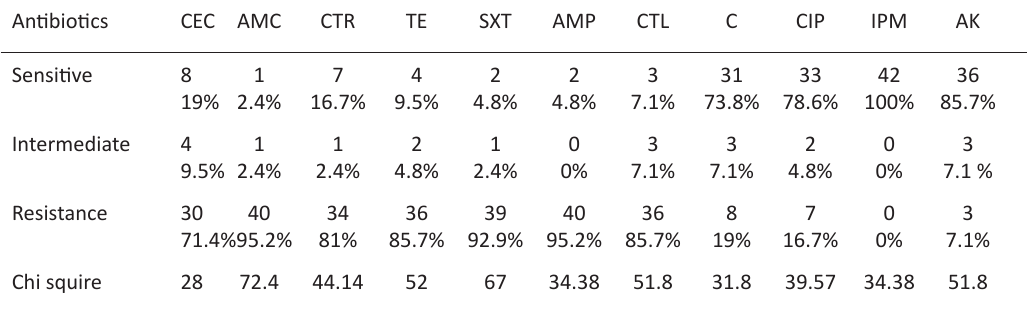
Table 2. Antibiotic susceptibility test Antibiotics CEC AMC Sensitive